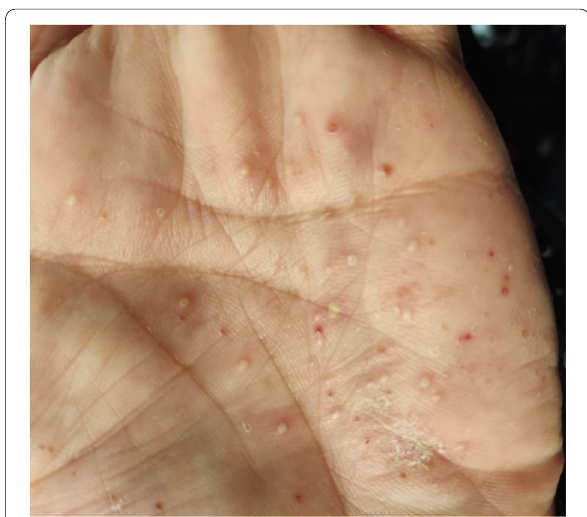
Fig. 1 Palmoplantar pustulosis (PPP). Small monomorphic pustules on both palms which erupted shortly after receiving first dose of covid-19 vaccine. Image 1 was obtained via Xiaomi Poco X3 Pro cellphone